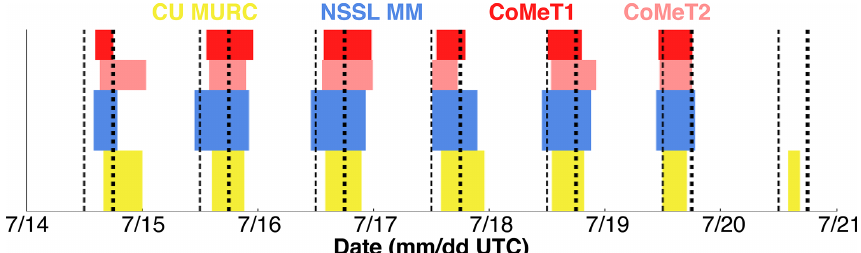
Figure 5. Illustration of the uptime for the mobile surface vehicles deployed during LAPSE-RATE. Shown is the update for the CU MURC (yellow), the NSSL MM (blue), and the UNL CoMeTs (red and pink). The thin dashed black lines indicate 06:00LT (Mountain Daylight Time), while the bold dashed black lines represent 12:00LT for each